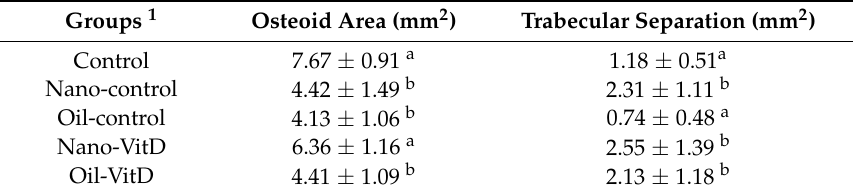
Figure 4. Histopathological changes in femur of rats receiving Oil-VitD vs. Oil-control after one week of treatment. Red arrows are plotting the osteoid area and the blue ones referring to the trabecular separation. Table 3. Histomorphometric parameters among study groups. When present, different superscripts within each column represent statistical differences after One-way ANOVA and Tukey’s HSD test ( p < 0.05).